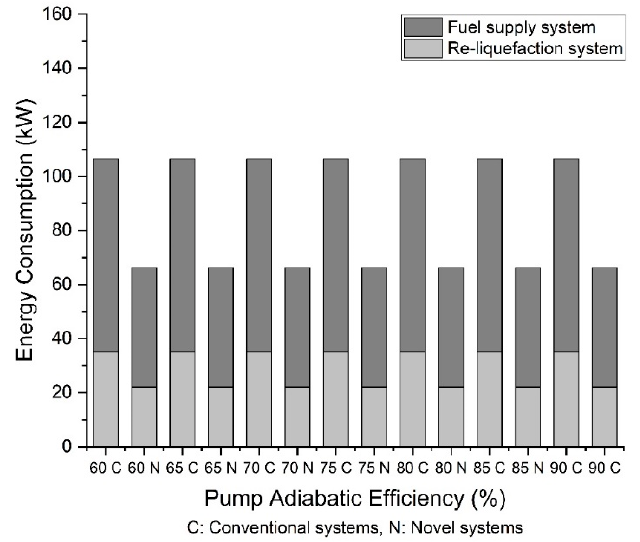
Figure 9. Energy consumption for conventional and novel re-liquefaction and fuel supply systems with pump adiabatic efficiencies.